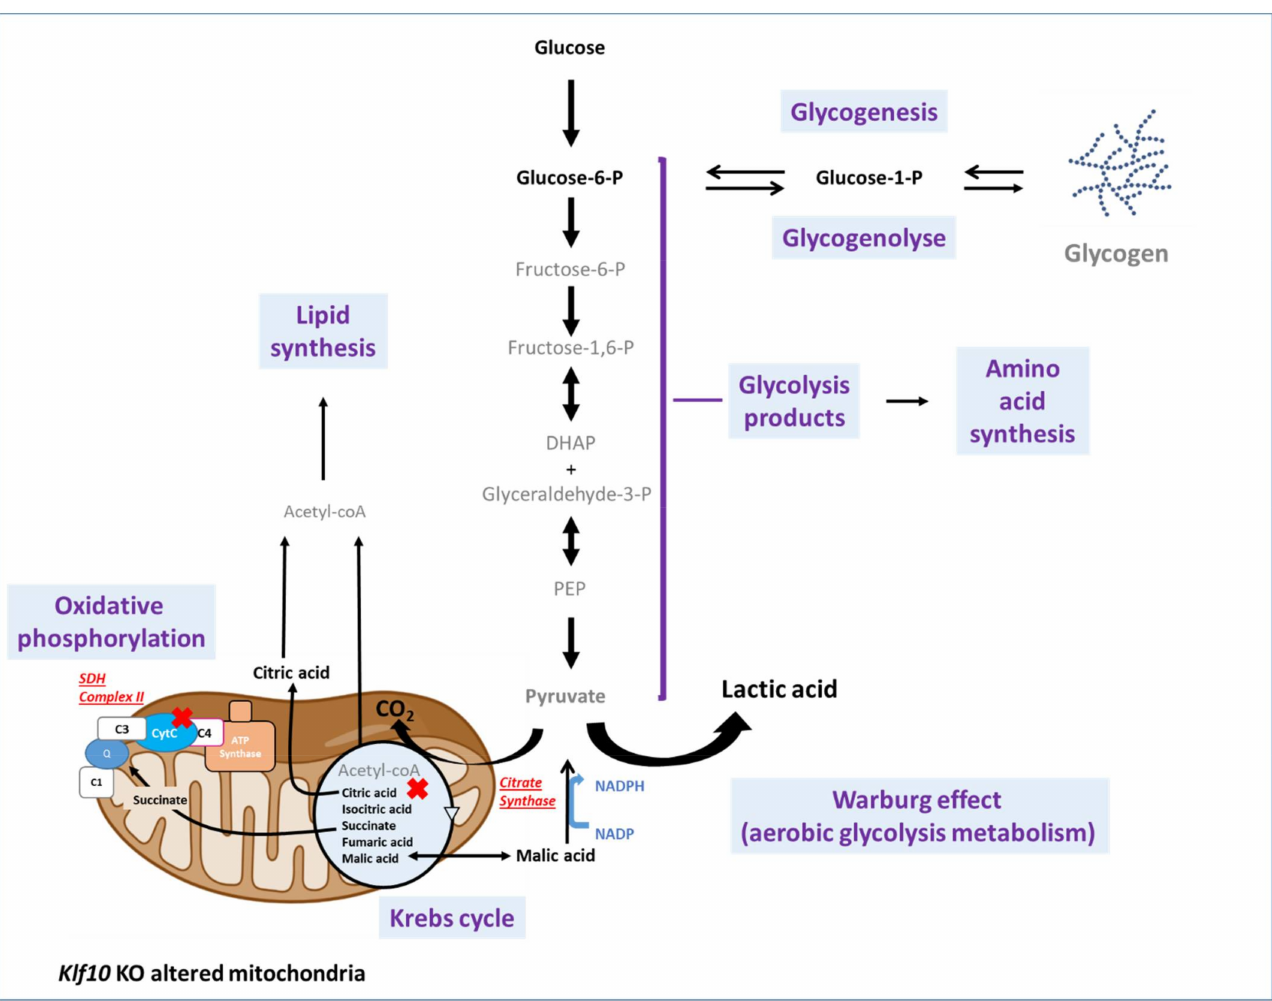
Figure 9. Model of metabolic pathways changes occurring in soleus of Klf10 KO. A summary of the biochemical pathways related to glucose metabolism in soleus. Metabolites that changed between Klf10 KO and wild-type mice are indicated in black bold. Red crosses are the metabolic situation and the name of the two enzymes implicated in the described deterioration of mitochondria functions in Klf10 KO mice (28). DHAP: Dihydroxyacetone phosphate; PEP: Phosphoenolpyruvate; SDH complex II: Succinate